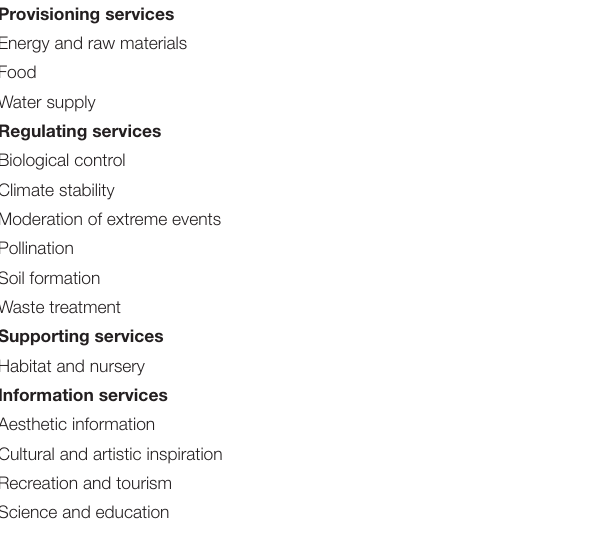
FIGURE 1 | Ecosystem service valuation